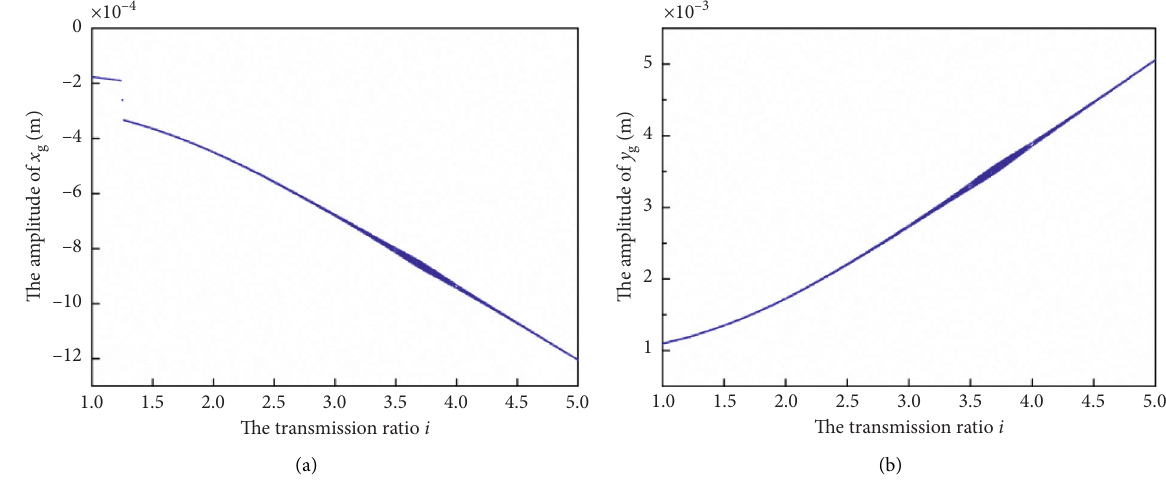
Figure 12: Bifurcation diagram of the driven gear: (a) in x direction and (b) in y